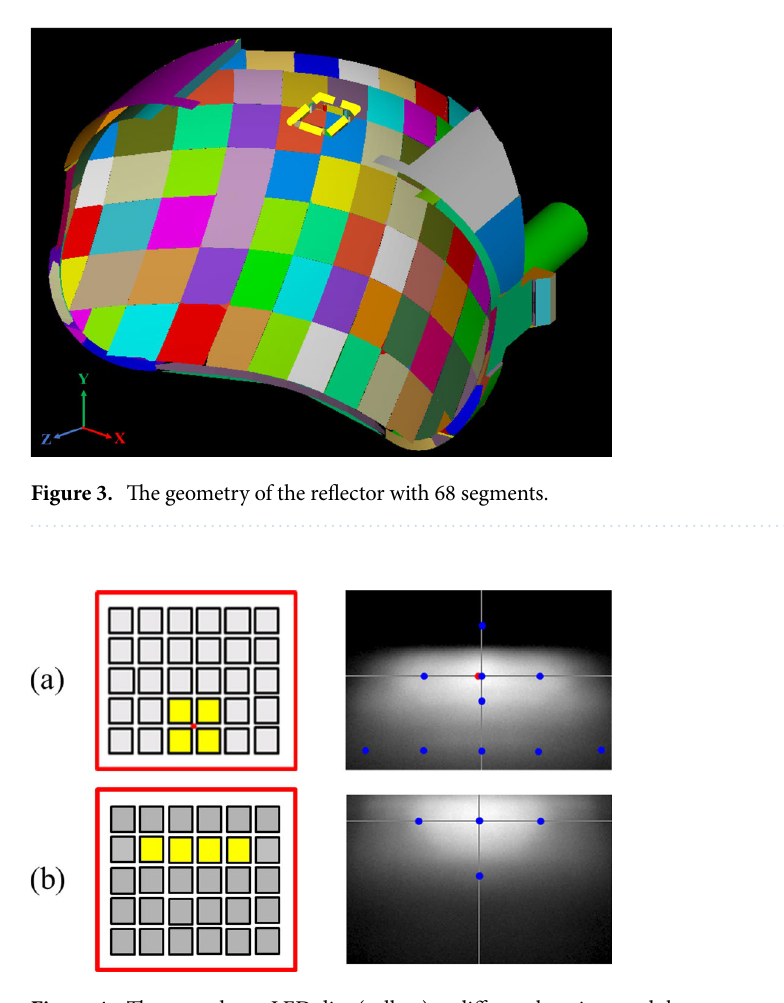
Figure 4. The turned-one LED dies (yellow) at different locations and the corresponding light patterns, where ( a ) is for low beam, and ( b ) is for high